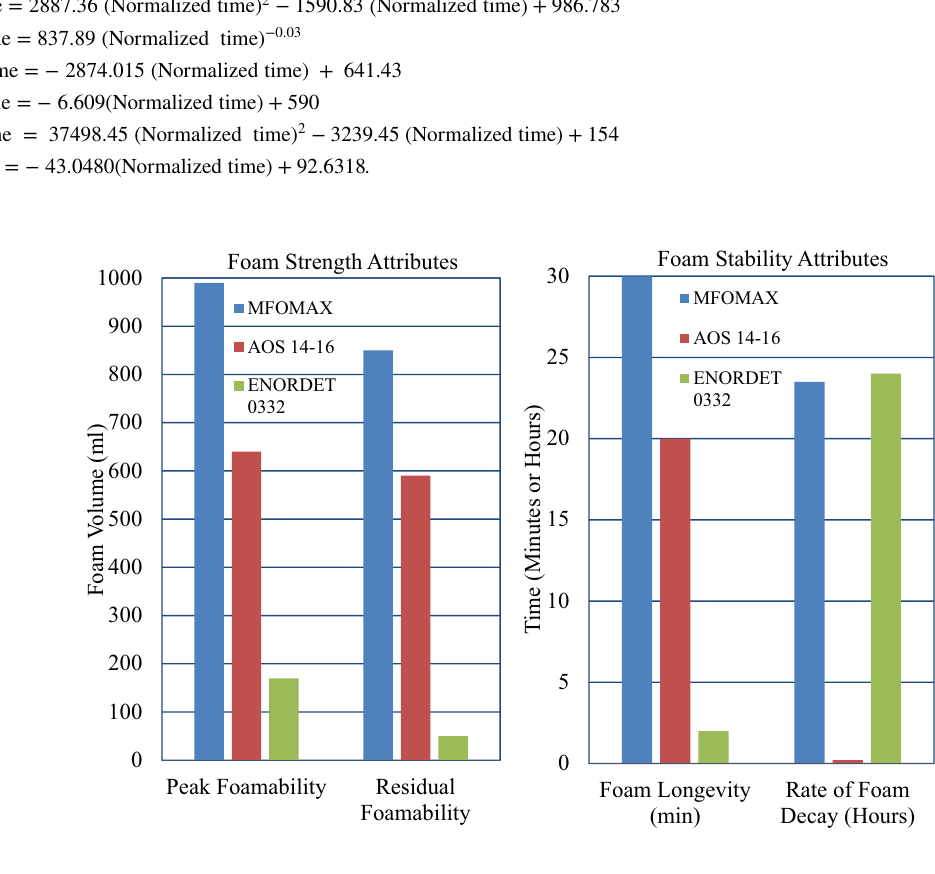
Decay behavior of bulk foam stability test was divided into two sections as early and late transient for a better understanding of trends in Figs. 8, 9 and 10.